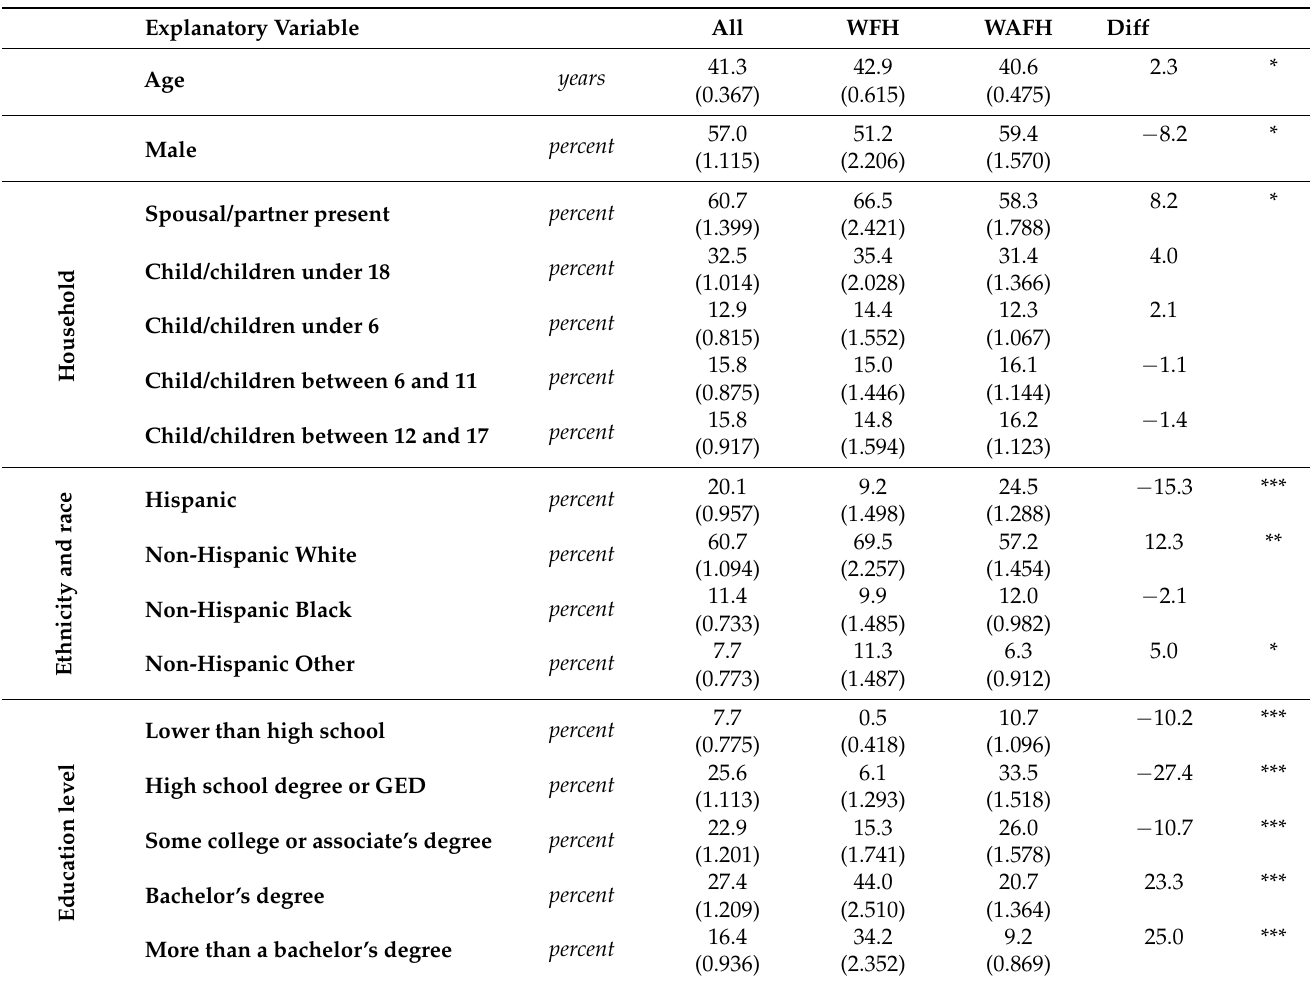
Table 1. Descriptive statistics, 2021 ATUS-WBM, overall and by WFH